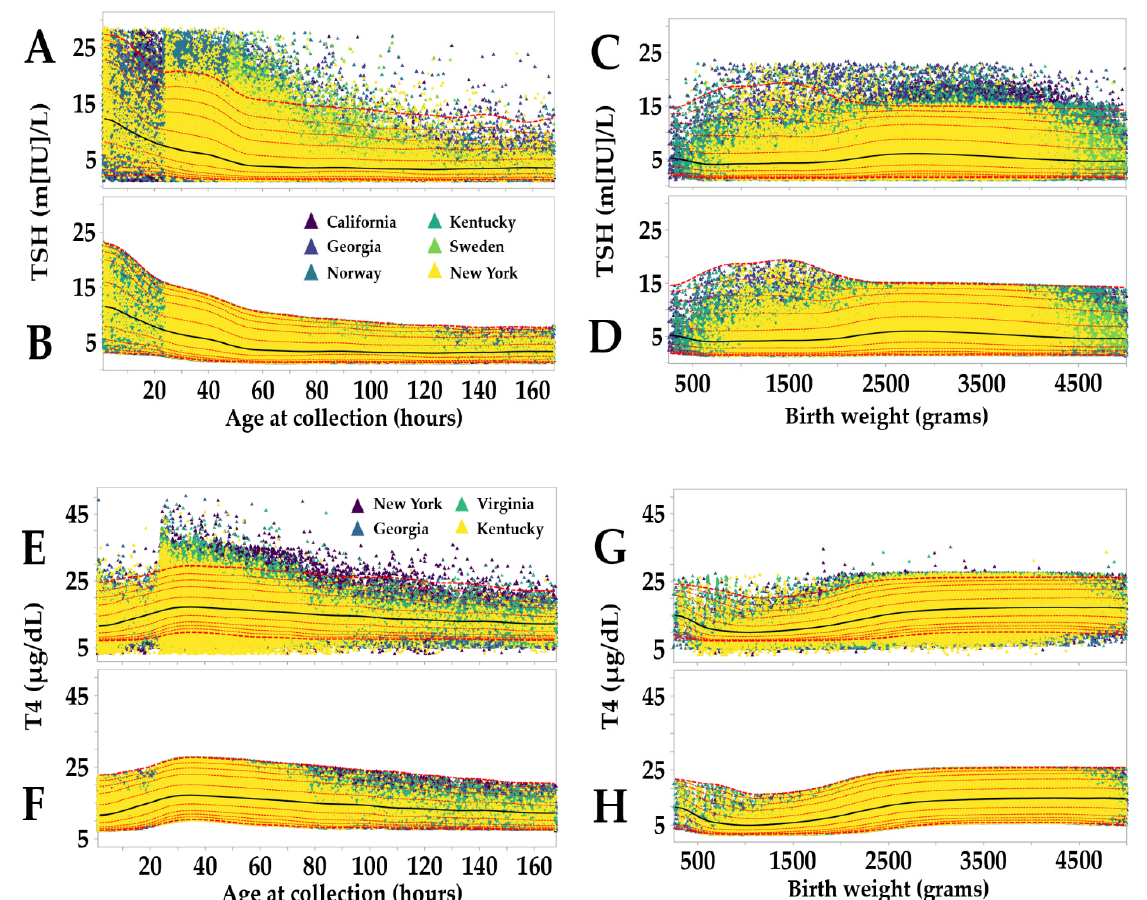
Figure 2. CLIR Reference Review tool (pre- and post-outlier removal by moving percentiles). Legend: Outlier removal by the CLIR Reference Data Review tool for markers TSH and T4. After the Data Validation tool, a first iteration of outlier removal (>99th percentile and <1st percentile; sorted by age panels A and E ; sorted by birth weight panels C and G ) was performed to transition from the uniform and inevitably flat-lined removal of outliers above and below the multiples of median (MoM) limits to a recognizable biological trend according to the selected covariate. Color coding of locations is embedded in panel B (TSH) and E (T4). Colors are assigned by count in descending order and are not the same for TSH and T4. (Panel A ): Overlay of individual points by location and moving percentiles (first iteration) of TSH over one week (168 h) of age at collection in 1-h increments. Percentiles shown in all panels are: 99th percentile (thicker dotted red line), 97.5th percentile, 95th percentile, 90th percentile, 75th percentile, 50th percentile (black continuous line), 25th percentile, 10th percentile, 5th percentile, 2.5th percentile, 1st percentile (thicker dotted red line). (Panel B ): Moving percentiles of TSH by age after second iteration of removal of values outside the peripheral percentiles. (Panel C ): Overlay of individual points by location and moving percentiles (first iteration, performed after removal of outliers by age) of TSH over the birth weight range 250–5000 g in 25 g increments. (Panel D ): Final moving percentiles of TSH by birth weight after the second iteration of removal of values outside the peripheral percentiles. (Panels E – H ): T4 percentiles following the same process described in panels A , D .